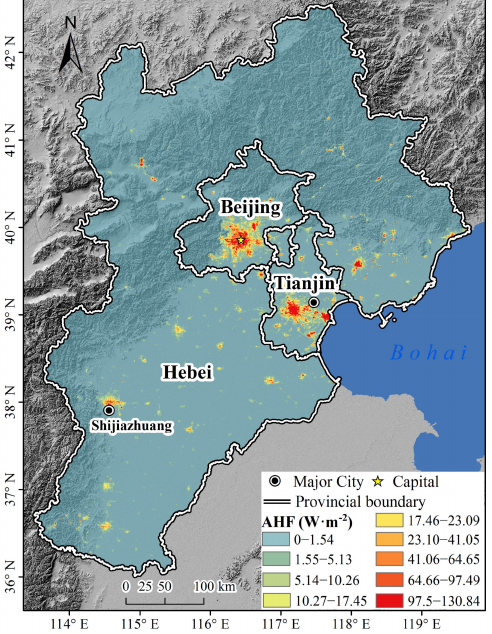
Figure 5. The RAHF results for the Beijing–Tianjin–Hebei region in the year 2015.